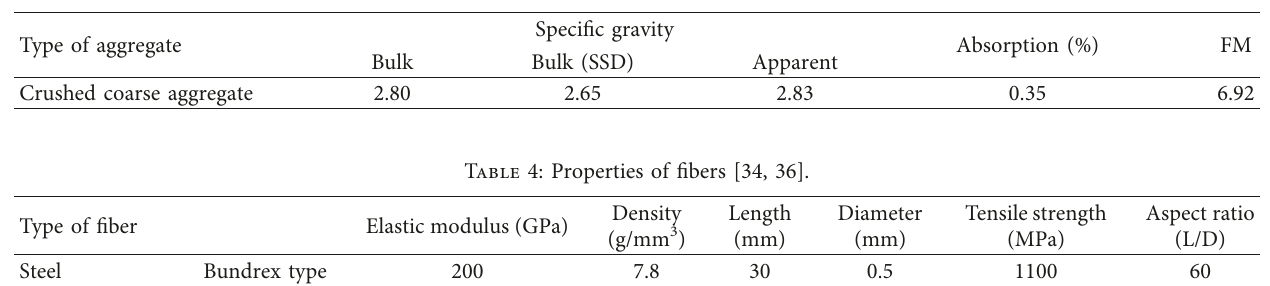
Table 3: Physical properties of coarse aggregate [34, 35].